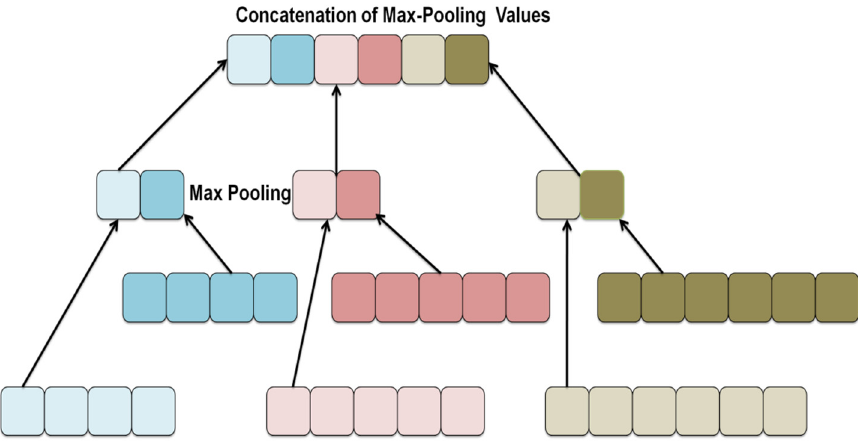
Figure 2. Framework of Hybrid Maxpool matrix.